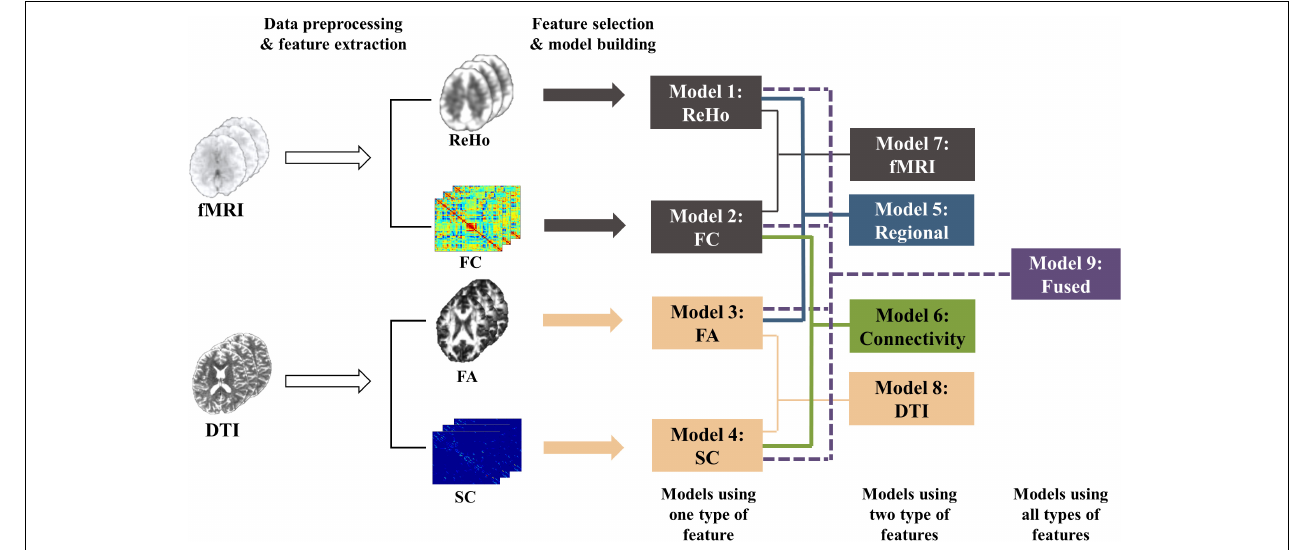
FIGURE 1 | The whole procedure of the pain threshold prediction analysis based on multi-features of multi-modal MRI.